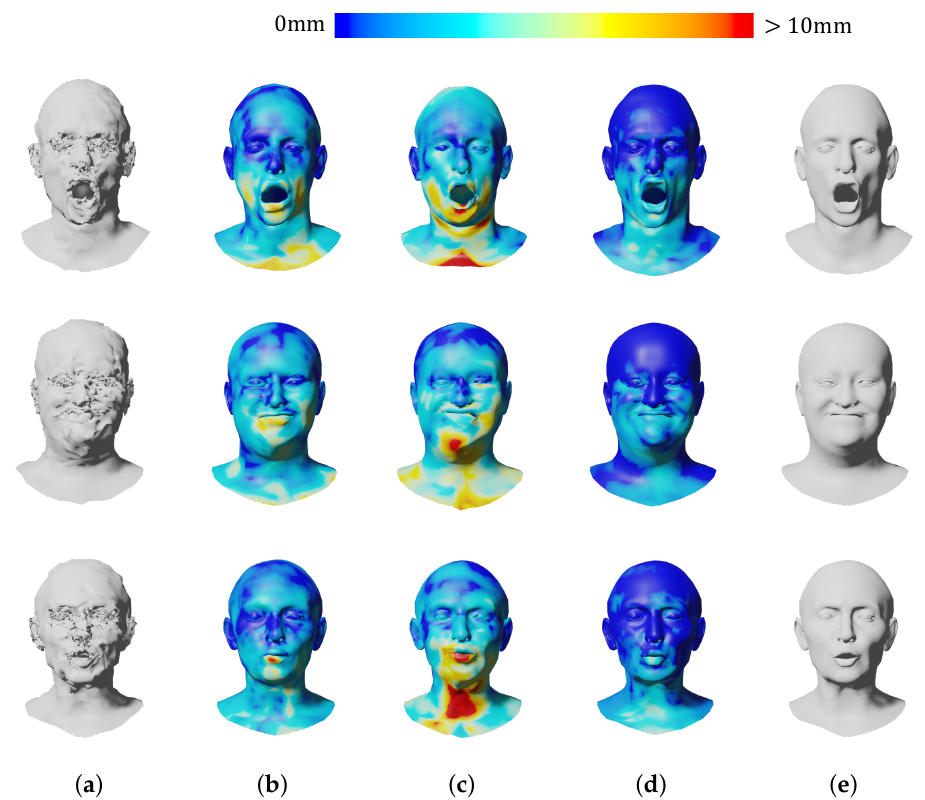
Figure 7. Qualitative comparison of shape denoising. ( a ) Input; ( b ) CoMA; ( c ) SpiralNet++; ( d ) Ours; ( e ) Ground